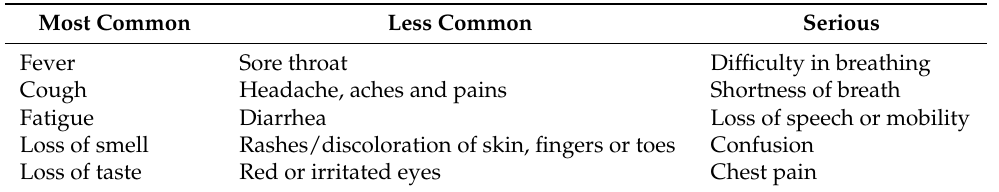
Table 5. Symptoms of COVID-19